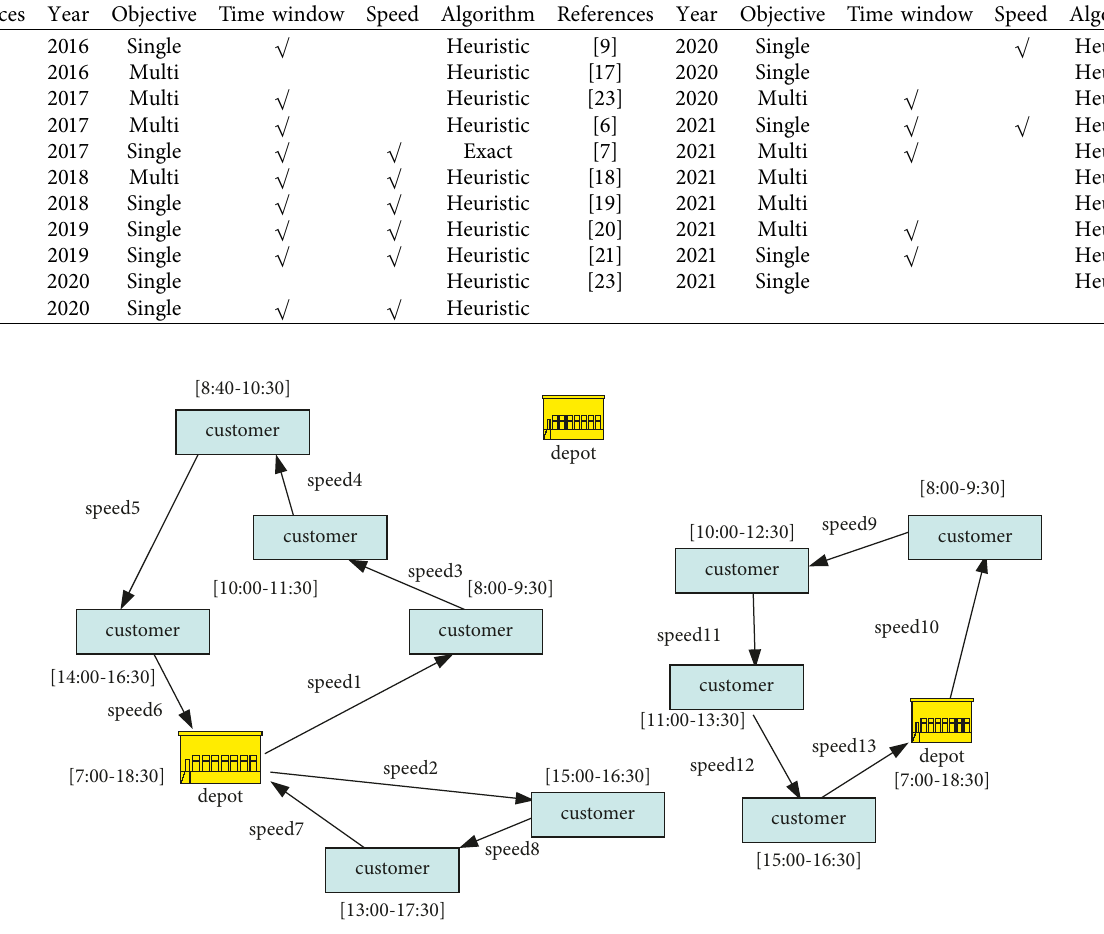
Figure 1: The diagram of the